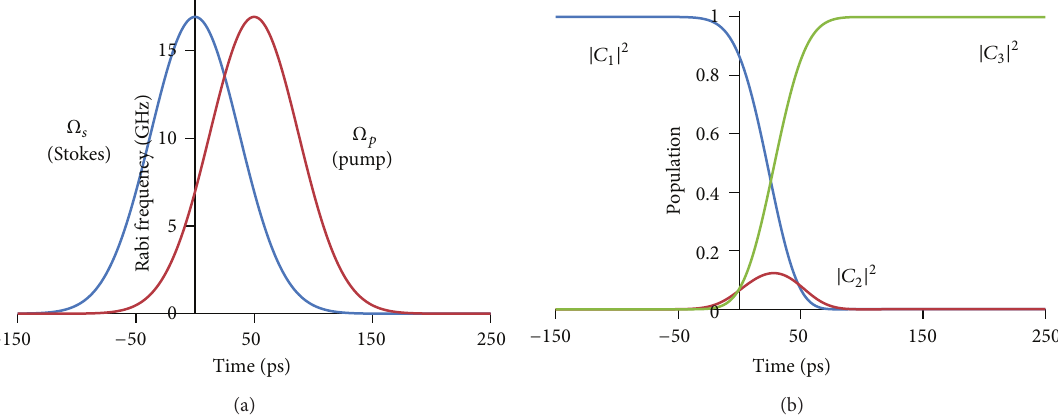
Figure 6: Rabi frequencies and population transfers as a function of time. (a) The Rabi frequencies of the pump and Stokes laser pulses. Note that the Stokes pulse (coupling states |2⟩ and |3⟩ ) precedes the pump pulse (coupling states |1⟩ and |2⟩ ). (b) The populations of states |1⟩ , |2⟩ , and |3⟩ as a function of time. Note that the population shifts from |1⟩ to |3⟩ during the time when the laser pulses overlap with very little population ever reaching state |2⟩ .